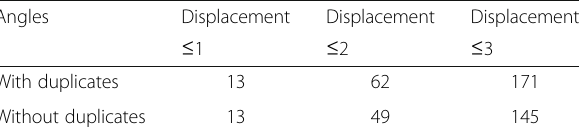
Table 1 Angle groups of two cases in Fig. 6 under